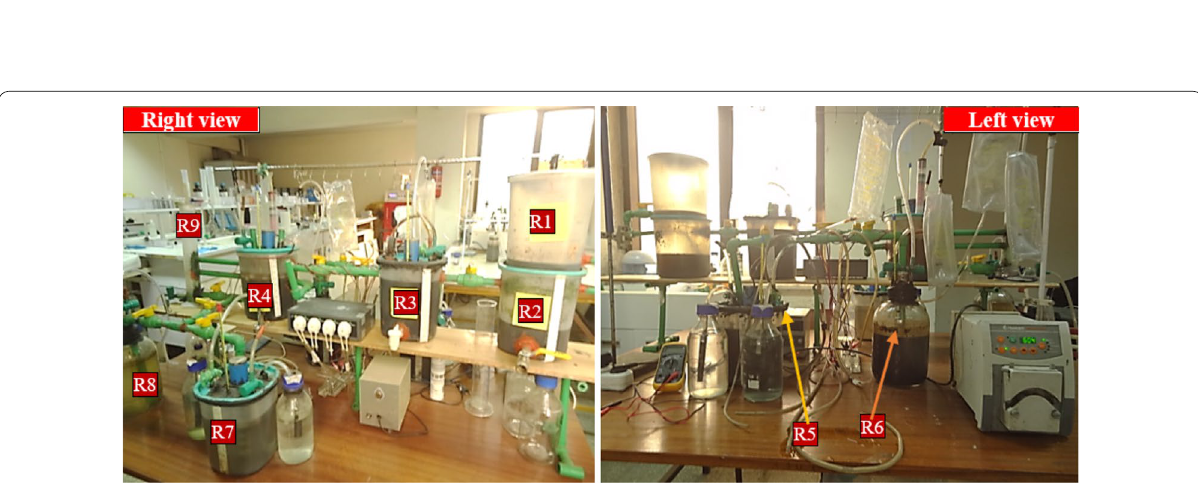
Fig. 3 Photo of the constructed MFC-integrated wastewater treatment system, right and left side view. R1–9 indicates the reactor number (for details, see Fig.